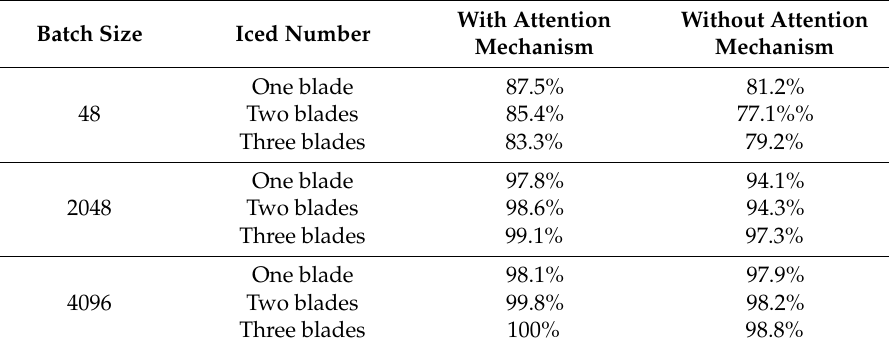
Table 4. The accuracies of models with di ff erent batch